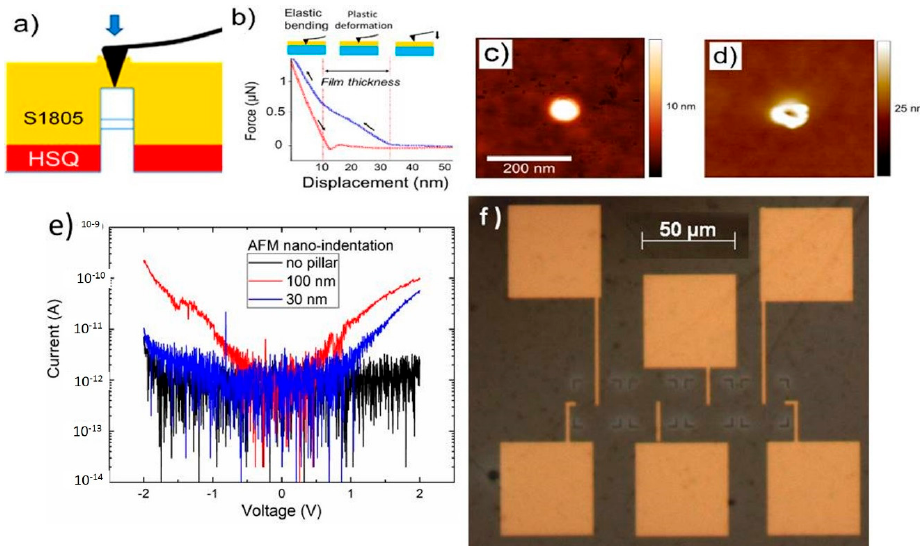
Figure 3. ( a ) Schematic of the AFM nano-indentation procedure. ( b ) Force distance curve acquired during indentation. ( c ) AFM image of a resist coated 30-nm diameter pillar before performing the nano-indentation. ( d ) AFM image of the same pillar after performing nano-indentation. ( e ) I-V curves after contacting two pillars, with diameters of 30 nm (blue) and 100 nm (red) by AFM indentation. In black, we show an I-V curve performed on a metal contact on top of an area without nano-pillar. ( f ) Optical image of contacted nano-pillars, pillars with different diameters are contacted, ranging from 100 nm (left) to 30 nm (right). Nanomaterials 2020 , 10 , x FOR PEER REVIEW